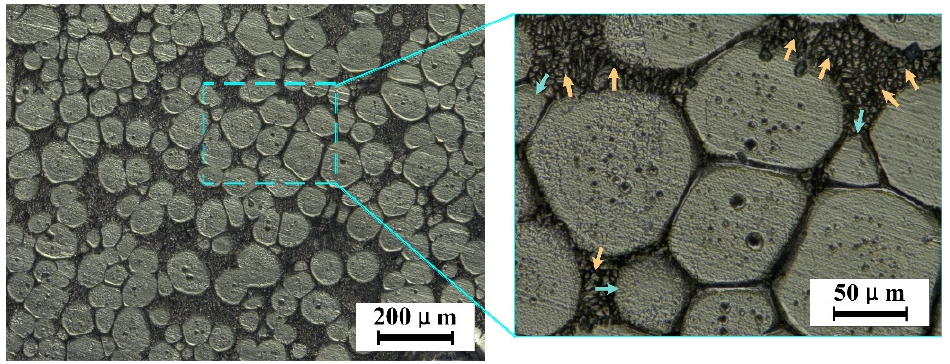
Figure 10. Coarsening of the α -Al grains.